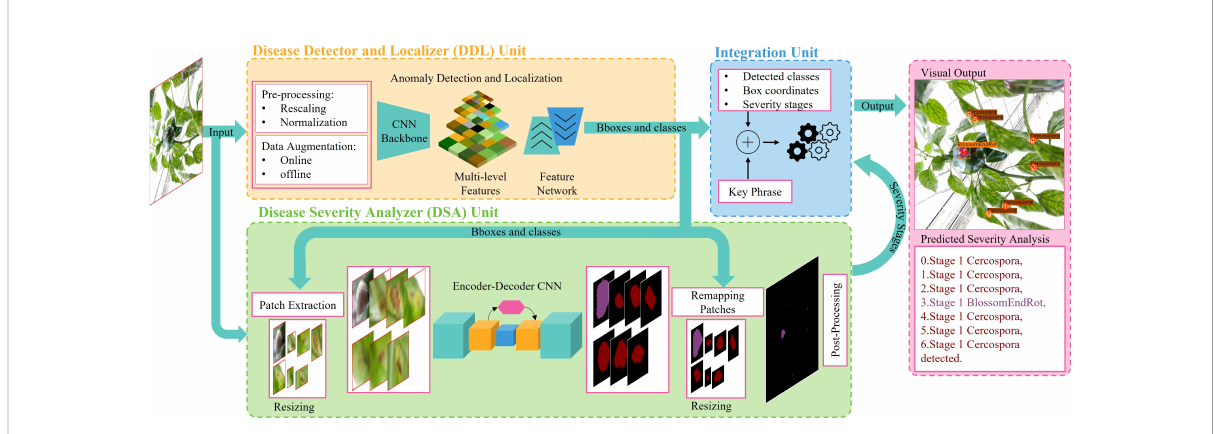
FIGURE 6 Flow diagram of the naïve framework. The overall architecture is composed of three main units. The DDL unit for generating reliable bounding boxes locating plant abnormalities. The DSA unit for analyzing and predicting intensity levels of abnormalities. An integration unit which combines the outcomes of both units to generate fi nal detailed